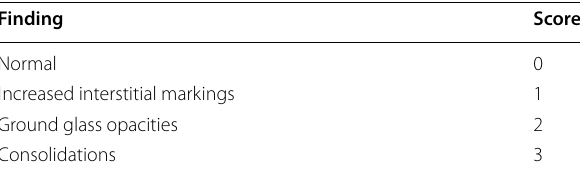
Table 1 Radiologist score (RADS) [9]